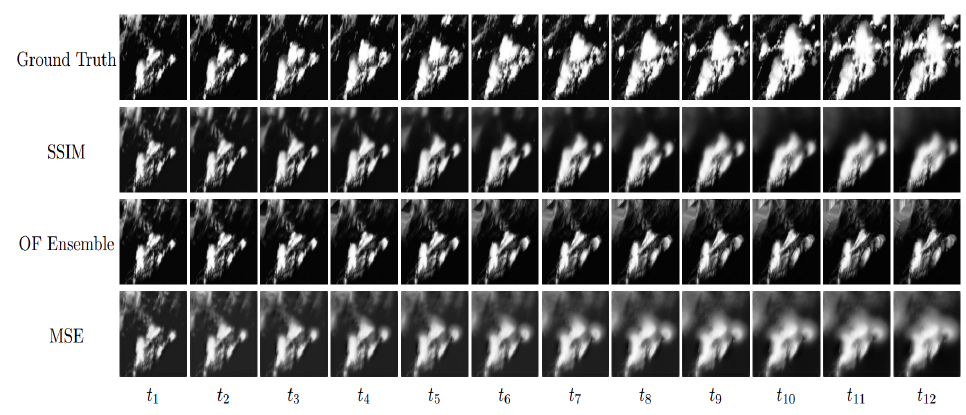
Figure 9. Example 3 h nowcasts over Austria and Switzerland on 1 July